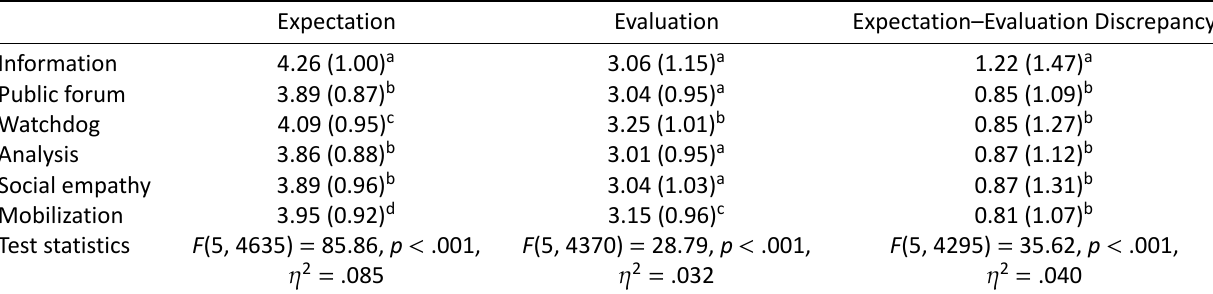
Table 2. Repeated-measures ANOVAs on differences in mean expectations, evaluations, and evaluation-expectation dis- crepancies for the six dimensions of normative media functions ( SD in